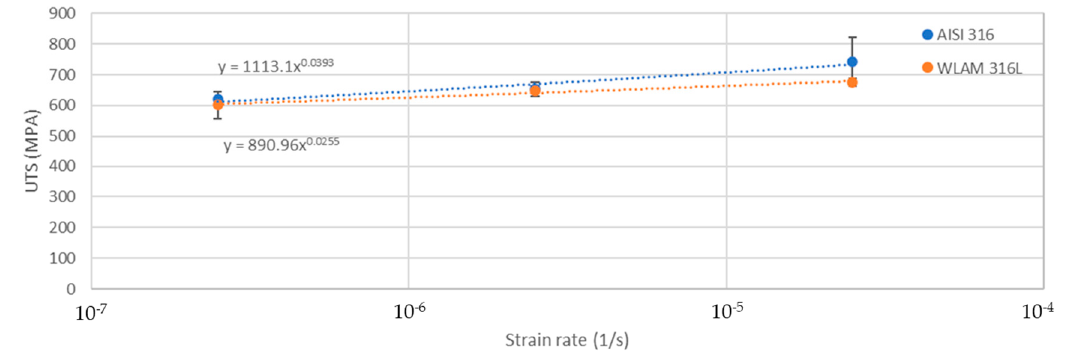
Figure 8. Ultimate tensile strength vs. strain rate of the WLAM samples and the counterpart AISI 316L alloy.